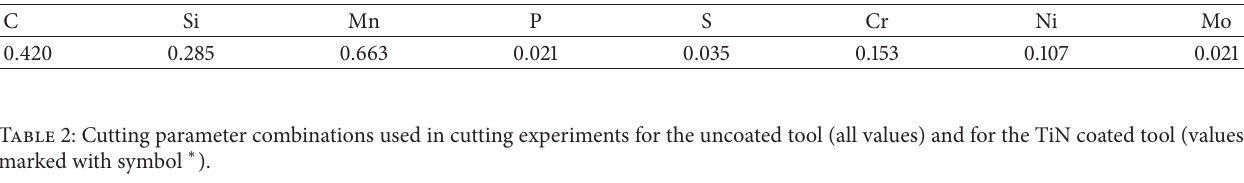
Table 1: Chemical composition of workpiece material (SAE 1045) in weight %.